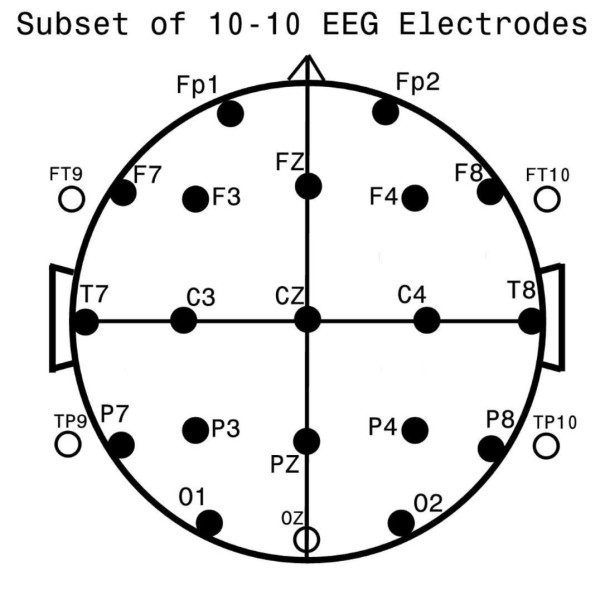
Standard EEG electrode names and positions. Head in vertex view, nose above, left ear to left. EEG electrodes, Z, Midline, FZ, Midline Frontal; CZ, Midline Central; PZ, Midline Parietal; OZ, Midline Occipital. Even numbers, right hemisphere locations; odd numbers, left hemisphere locations, Fp, Frontopolar; F, Frontal; C, Central; T, Temporal; P, Parietal; O, Occipital. The standard 19, 10 to 20 electrodes are shown as black circles. An additional subset of five, 10-10 electrodes are shown as open circles.